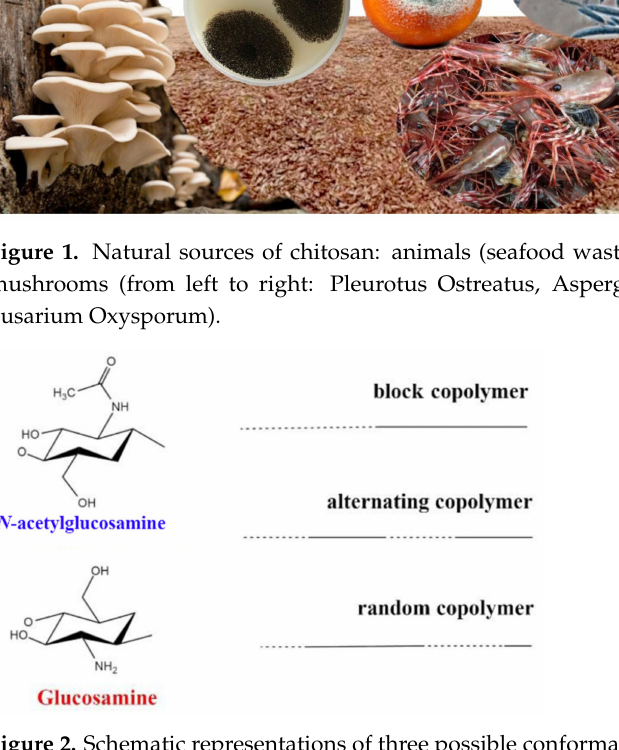
Figure 2. Schematic representations of three possible conformations for chitosan copolymers. The chemical structures of the two repetitive units are represented on the